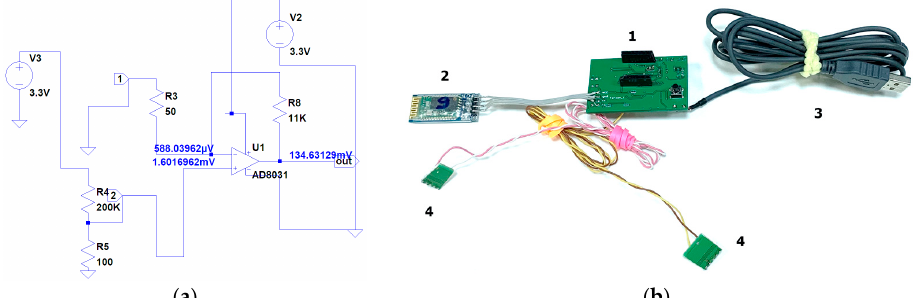
Figure 2. ( a ) Developed electronic circuit; ( b ) electronic microcontroller circuit layout, where 1—